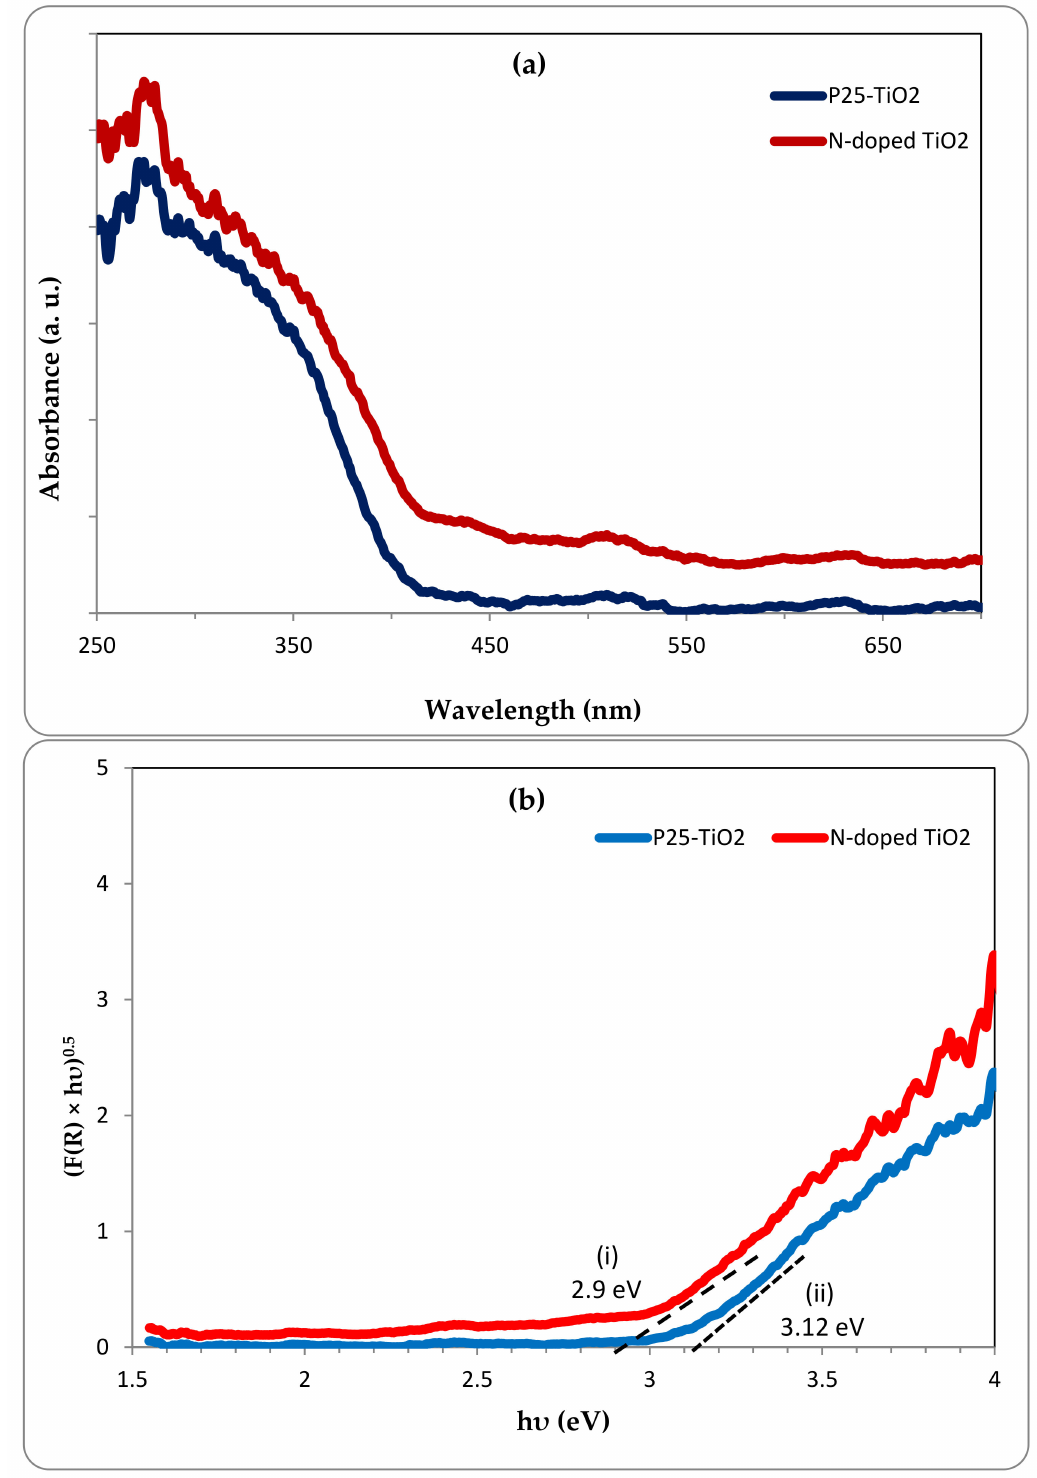
Figure 7. ( a ) UV-Vis diffuse reflectance spectra and, ( b ) plots of the transformed Kubelka-Munk function vs the photon energy for N-doped TiO 2 and pristine P25-TiO 2